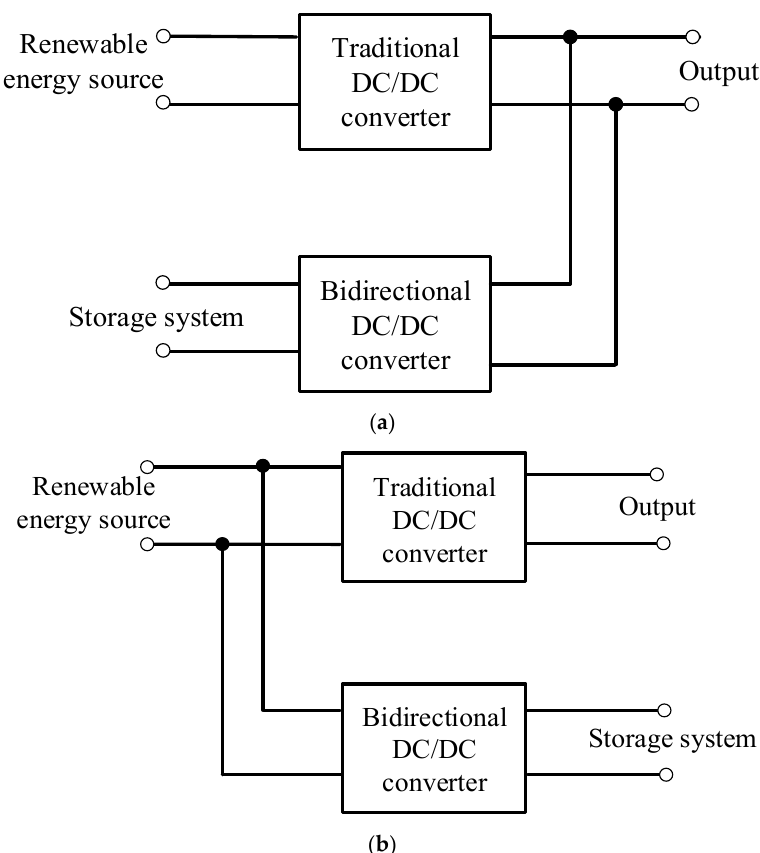
Figure 1. The structures of traditional DEGS ( a ) type 1; ( b ) type 2.